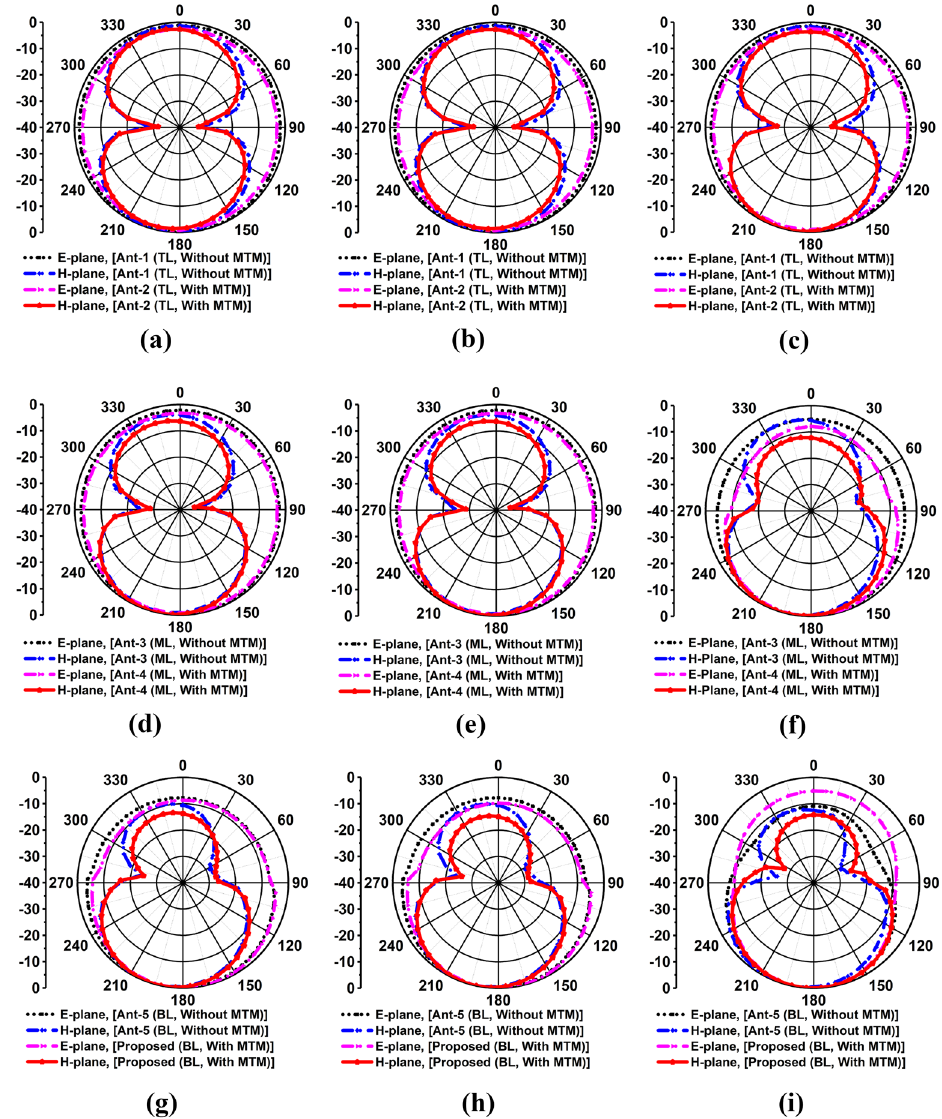
Figure 11. Simulated 2D radiation pattern (Far-field) in E-plane and H-plane of the antenna’s evolution for: ( a ) Ant-1 and Ant-2 at 2.24 GHz; ( b ) Ant-1 and Ant-2 at 2.66 GHz; ( c ) Ant-1 and Ant-2 at 2.84 GHz; ( d ) Ant-3 and Ant-4 at 2.24 GHz; ( e ) Ant-3 and Ant-4 at 2.66 GHz; ( f ) Ant-3 and Ant-4 at 2.84 GHz; ( g ) Ant-5 and proposed at 2.24 GHz; ( h ) Ant-5 and proposed at 2.66 GHz; ( i ) Ant-5 and proposed at 2.84